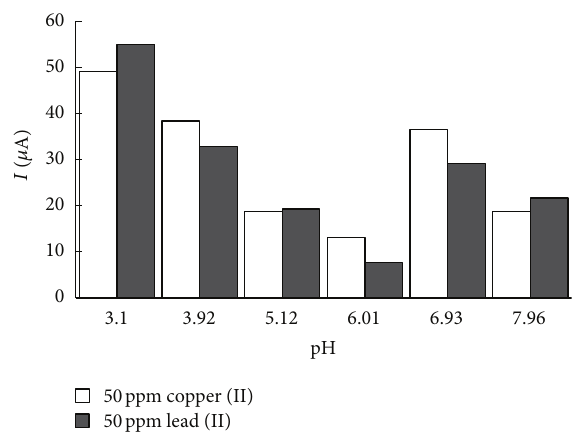
Figure 7: Pb(II) and Cu(II) analyses in electrolyte of various pH values using Acetabularia -CPE. Cu(II) analysis was carried out with 1 minute of deposition potential of − 300mV and scan rate of 100mV/s, whereas lead (II) was carried out with 1 minute deposition potential of − 800 mV and scan rate of 75